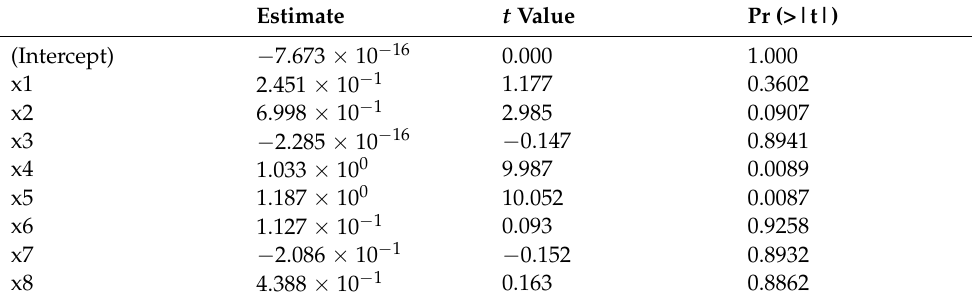
Table 8. Regression results.